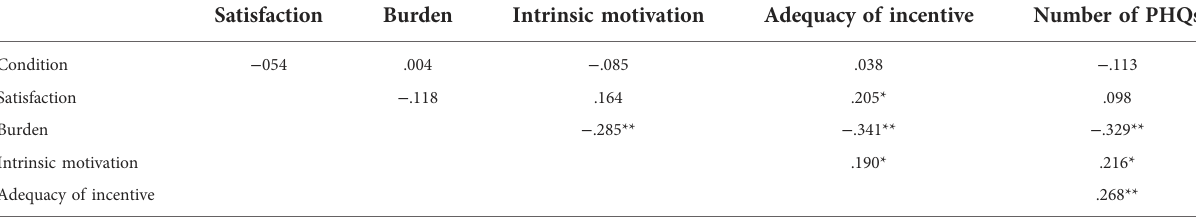
TABLE 4 Correlation table of condition, mechanisms, and number of PHQs completed.